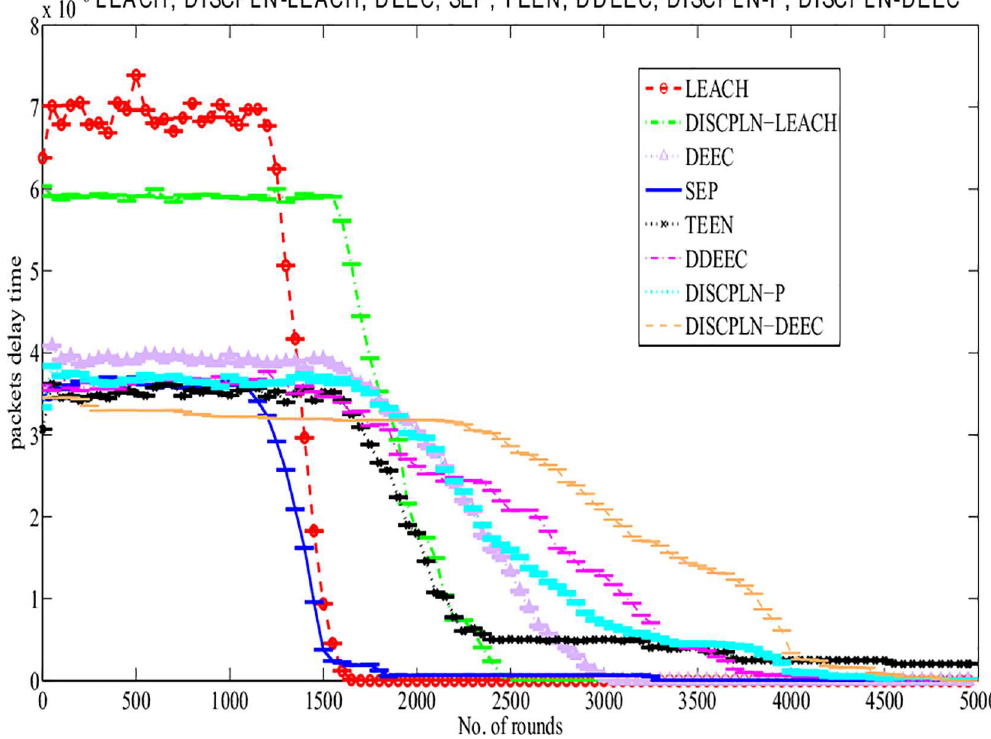
Fig 9. Numberof delayed packets for